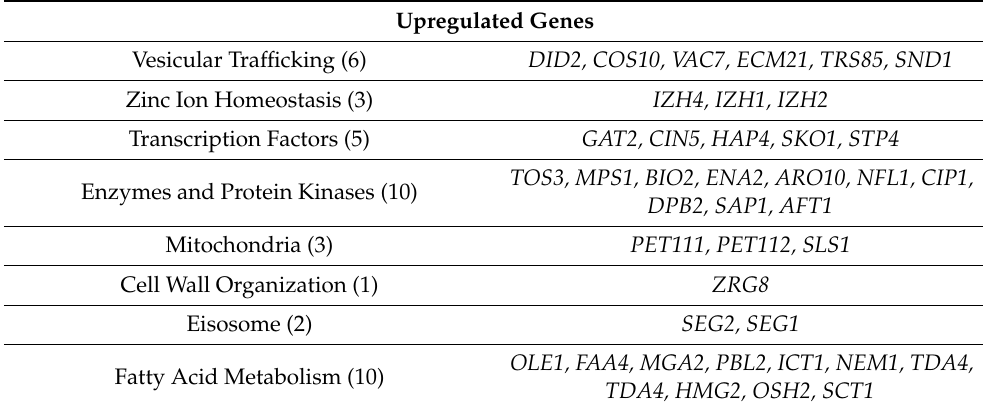
Table 5. Upregulated genes that showed the impact of red CdSe/ZnS QDs on membrane trafficking, metabolism, and cellular processes. Genes are sorted by protein class.